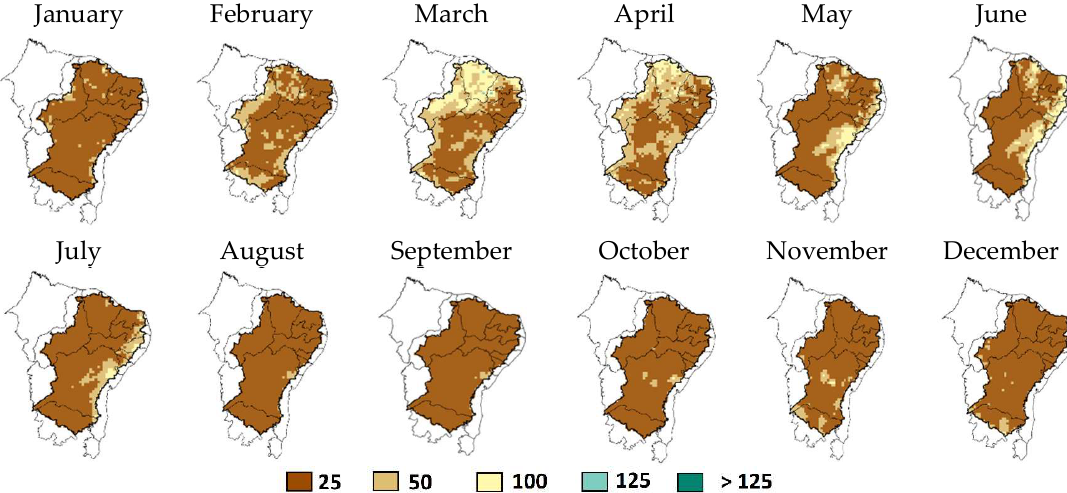
Figure 9. Monthly average spatial-temporal distribution of the soil water storage [mm] derived from MUSA model at 1 m depth in the Brazilian semiarid during 2015.